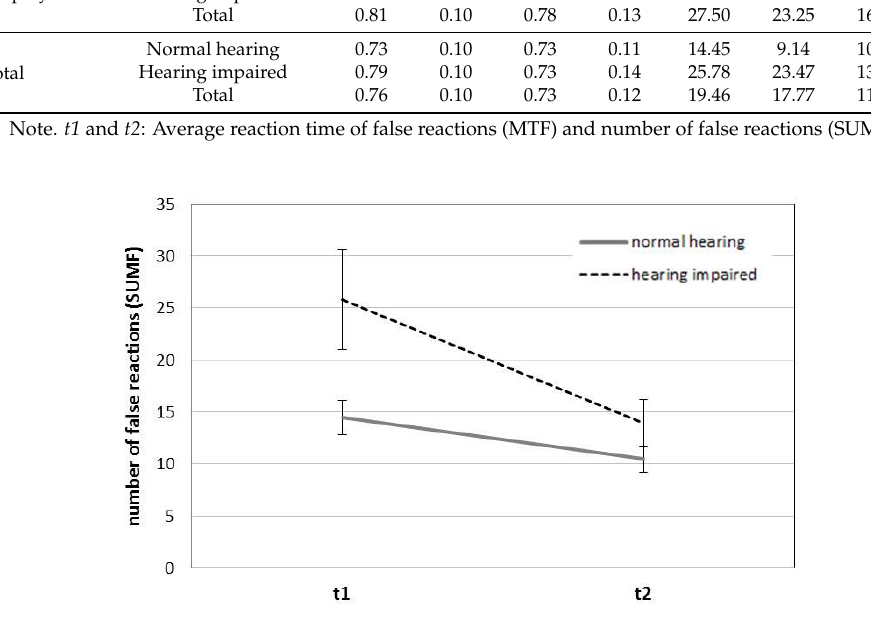
Figure 1. Long-term selective attention and concentration—number of false reactions: interaction hearing impairment x time of measurement. Note. Error bars reflect standard error of mean.